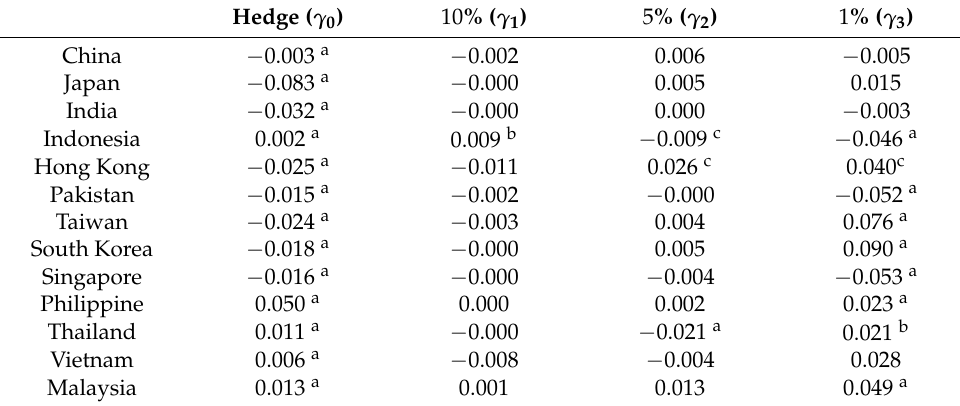
Table 2. Estimation results for the hedge and safe-haven properties of gold against Asian equities in extreme market conditions (quantile columns (10%, 5%, or